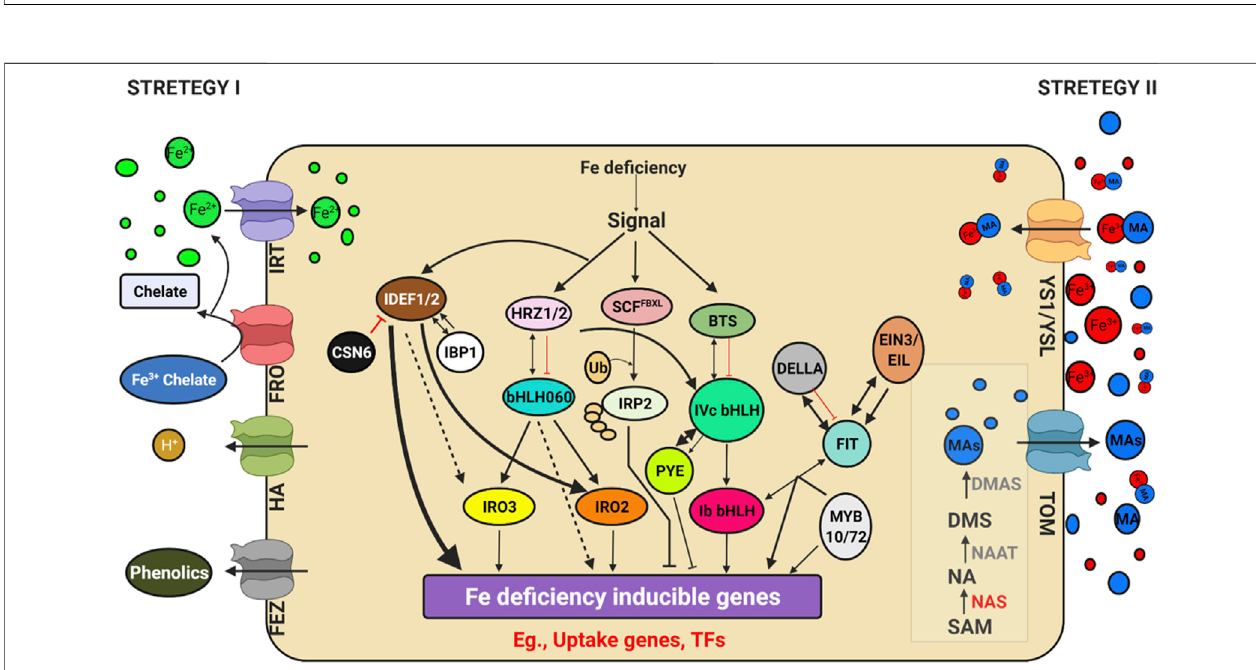
FIGURE 4 | SchematicmodeldepictingGenesregulatingiron(Fe)uptakeand de fi ciencyresponse.Illustrationwas madewithBiorender(https://biorender.com/).The possible negative regulators and genome editing targets are indicated with a scissor sign.